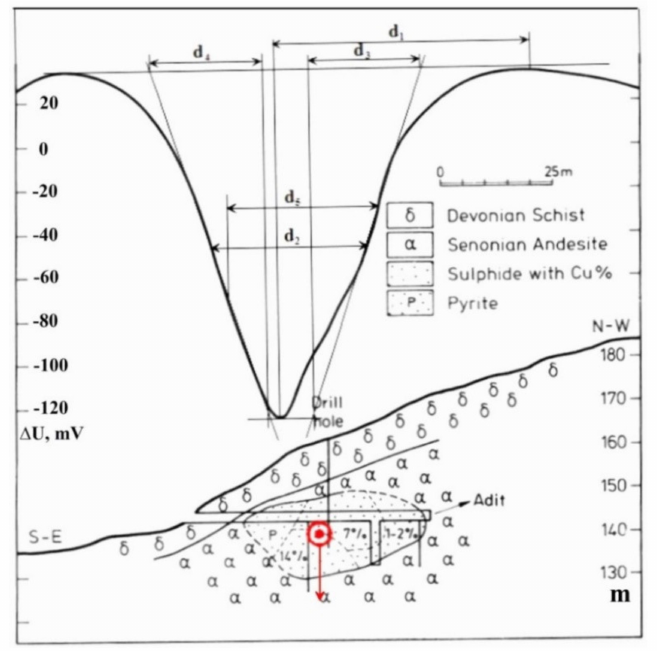
Figure 5. Quantitative interpretation of SP anomaly by the characteristic point and tangent methods in the Sariyer area, Turkey. The “ (cid:12) ” symbol marks the obtained position of the ore body center (approximated by a HCC). The red arrow shows the direction of self-polarization vector. Observed SP curve and geological section are taken from